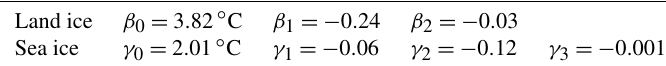
Table 5. Uncertainty model regression coefficients.